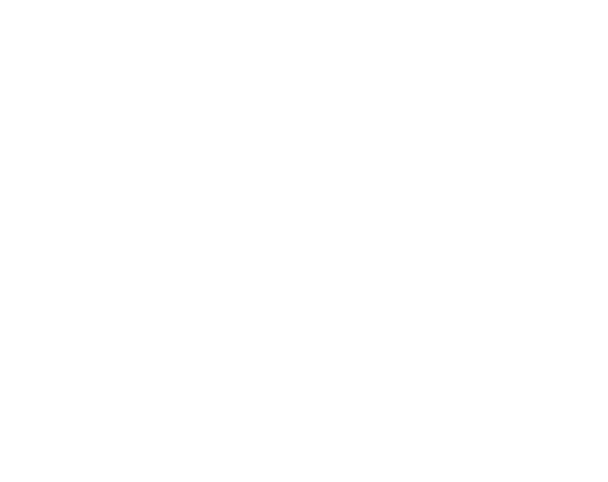
Table 4. The weight of each